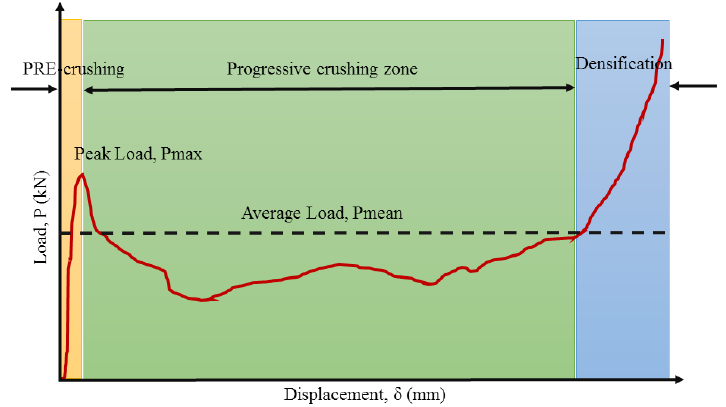
Figure 1. Energy absorption stages explained on load–displacement